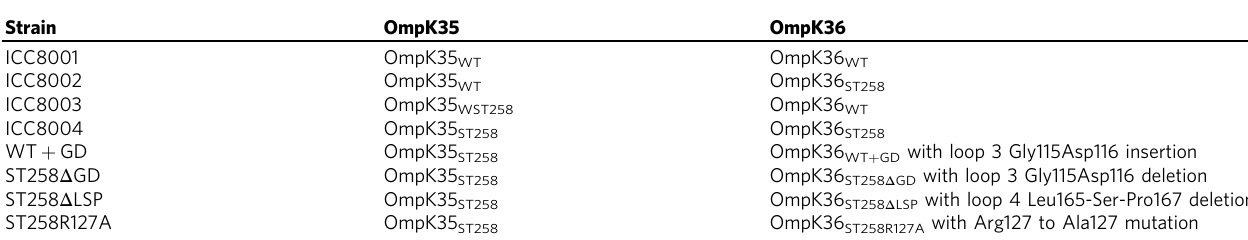
Table 1 Isogenic strains used in this study with their corresponding OmpK35 and OmpK36 composition Strain OmpK35 OmpK36